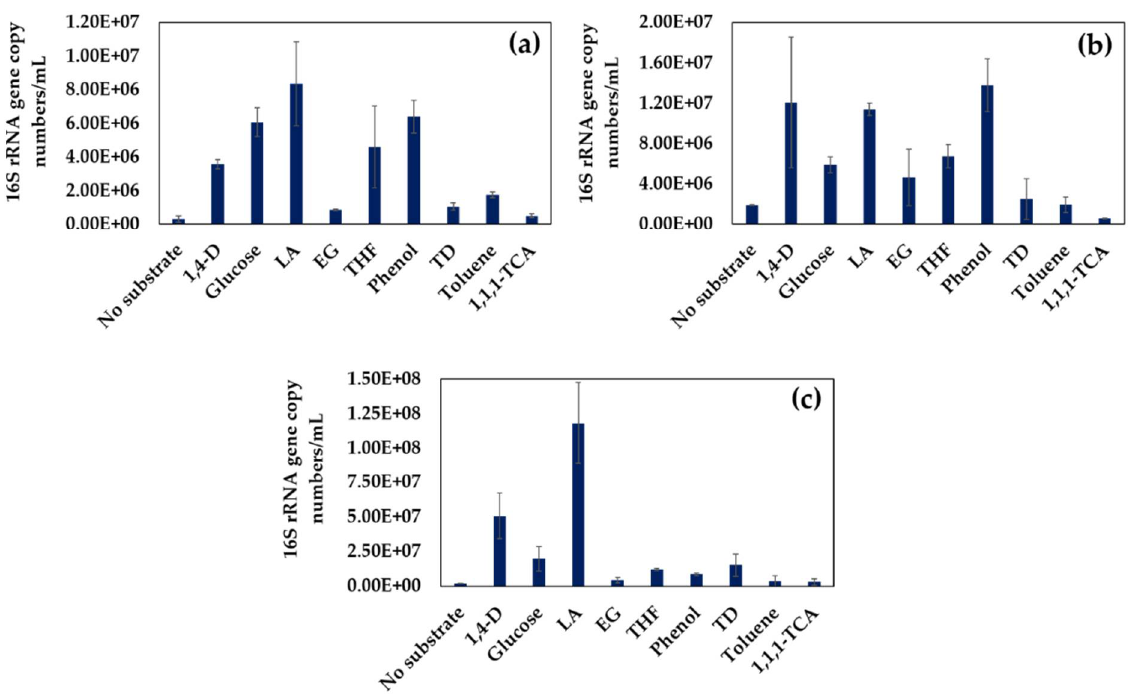
Figure 5. Ability of the strains TS28 ( a ), TS32 ( b ), and TS43 ( c ) to utilize various organic compounds (100 mg-C/L) as a growth substrate. Data shown are the cell growth measured as 16S rRNA gene copy numbers/mL after 7-day incubation experiments. The initial cell concentration was 100, 134, and 238 mg-fresh cell/L for strain TS28, TS32, and TS43, respectively. Error bars represent the MD from the duplicate experiments.